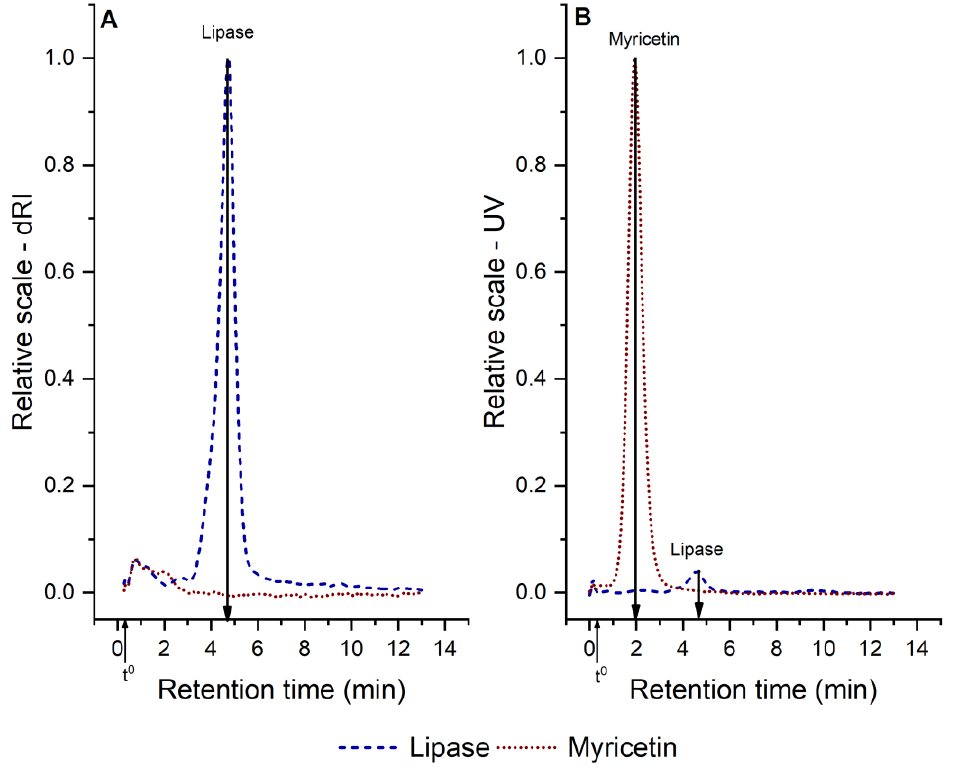
Figure 2. AF4–dRI ( A ) and UV ( B ) fractograms for pure lipase and pure myricetin solution. The injected mass is 25 µg lipase and 16 µg myricetin, respectively. t 0 denotes the void time at 19 sec.